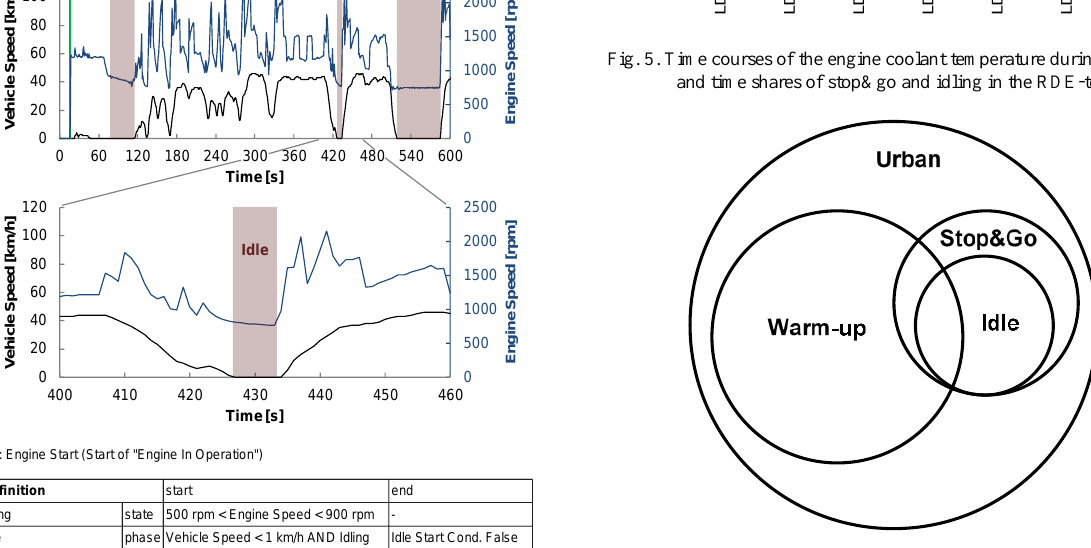
Fig. 6. Qualitative overlapping of the analyzed